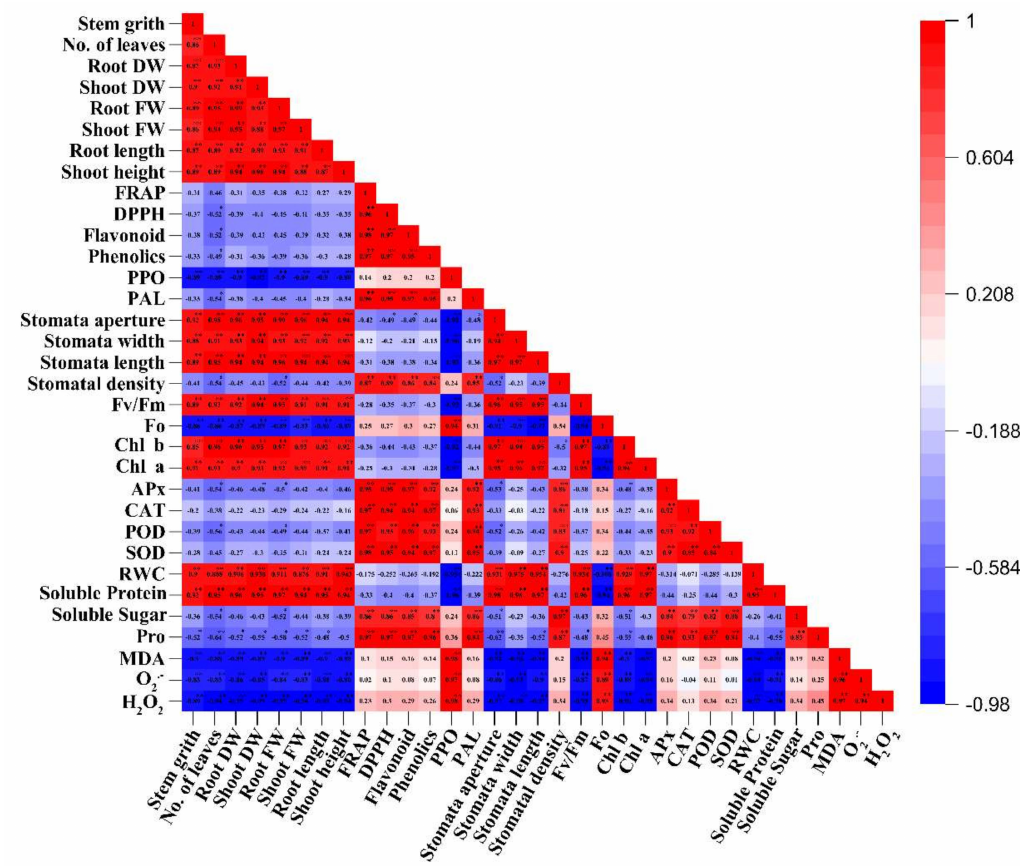
Figure 7. The Pearson‘s correlation analysis performed among reactive oxygen species (ROS), MDA, plant growth parameters, chlorophyll pigments, photosynthesis rate, stomata properties, and di ff erent physiological trials, after melatonin treatment under drought stress. Here, SFW—shoot fresh weight, SDW—shoot dry weight, RFW—root fresh weight, RDW—root dry weight, Chl a—chlorophyll a, Chl b—chlorophyll b, RWC—relative water content, Pro—proline, **—indicates 1% significant ( p ≤ 0.01), and *—indicates 5% significant ( p ≤